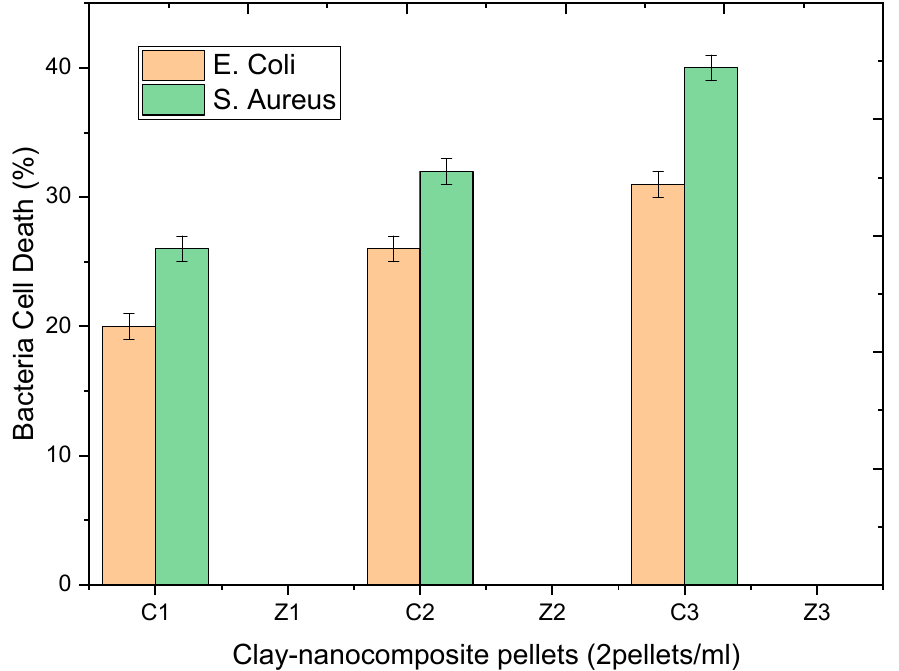
Figure 21. Histogram of the antibacteria activity of clay–nanocomposites pellets against E. coli and S. aureus in broth media after 24 h of incubation. C1, C2, C3, Z1, Z2 and Z3 respectively relates to: clay/CuO/Ag-1, clay/CuO/Ag-2, clay/CuO/Ag-3, clay/ZnO/Ag-1, clay/ZnO/Ag-2 and clay/ZnO/Ag-3 (Z1, Z2 and Z3 are empty because there was no any recorded inhibition of the bacterial species in the broth media).